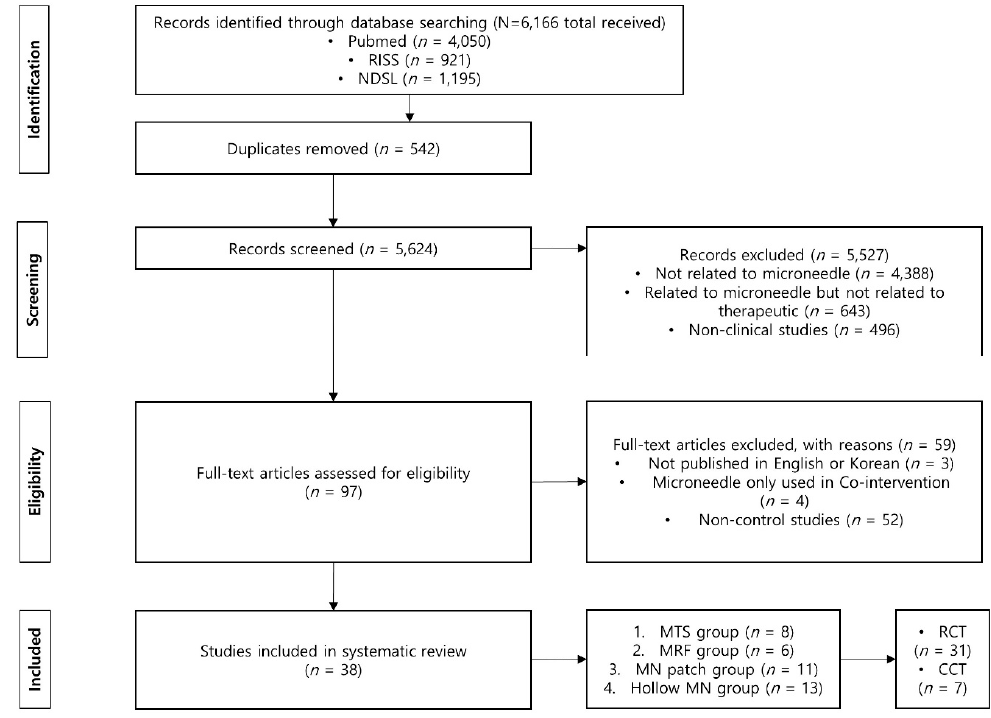
Figure 1. Flow chart for selection of studies.